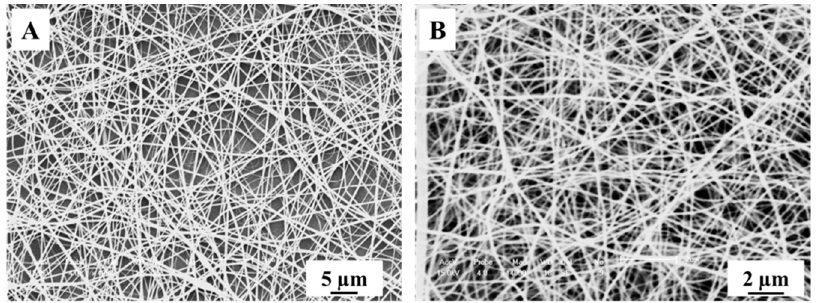
Figure 1. SEM images of electrospun nanofibers: ( A ) electrospun PVP/Ti(OBu) 4 composite nanofibers; ( B ) TiO 2 nanofibers calcined in air at 500 °C for 5 h.